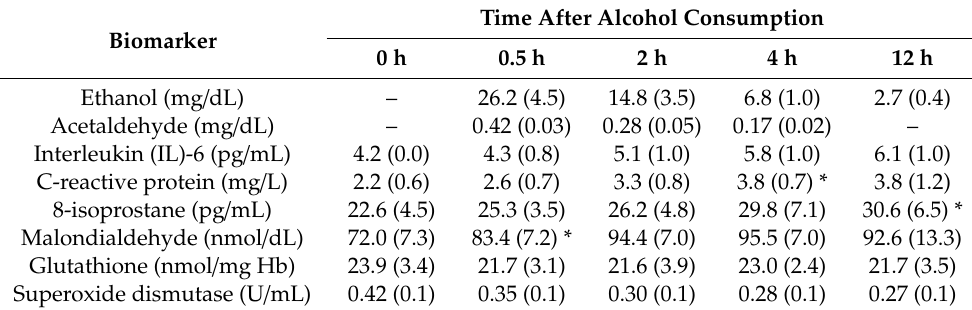
Table 2. Biomarkers of alcohol metabolism, oxidative stress and the inflammatory response to alcohol consumption and their relation to hangover